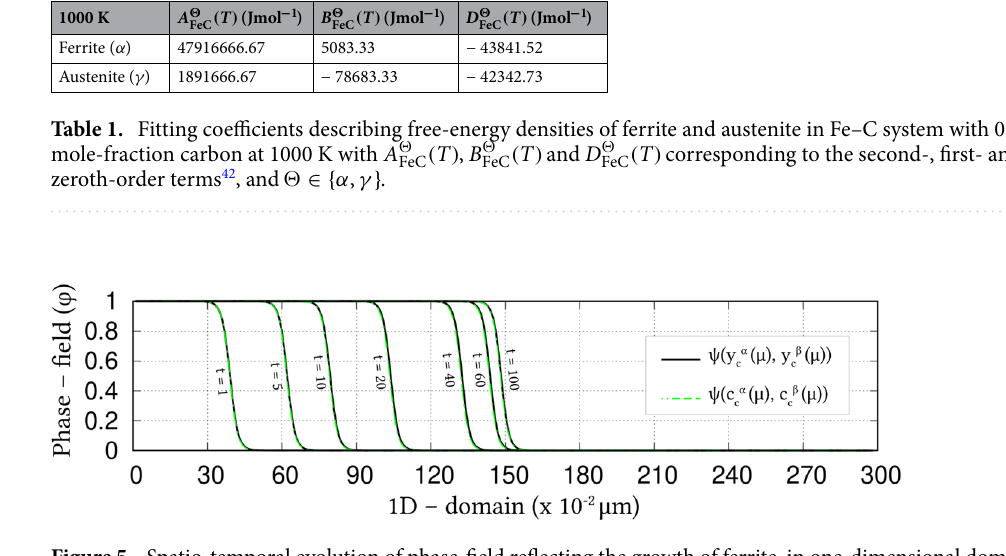
β C (µ)) ), through the